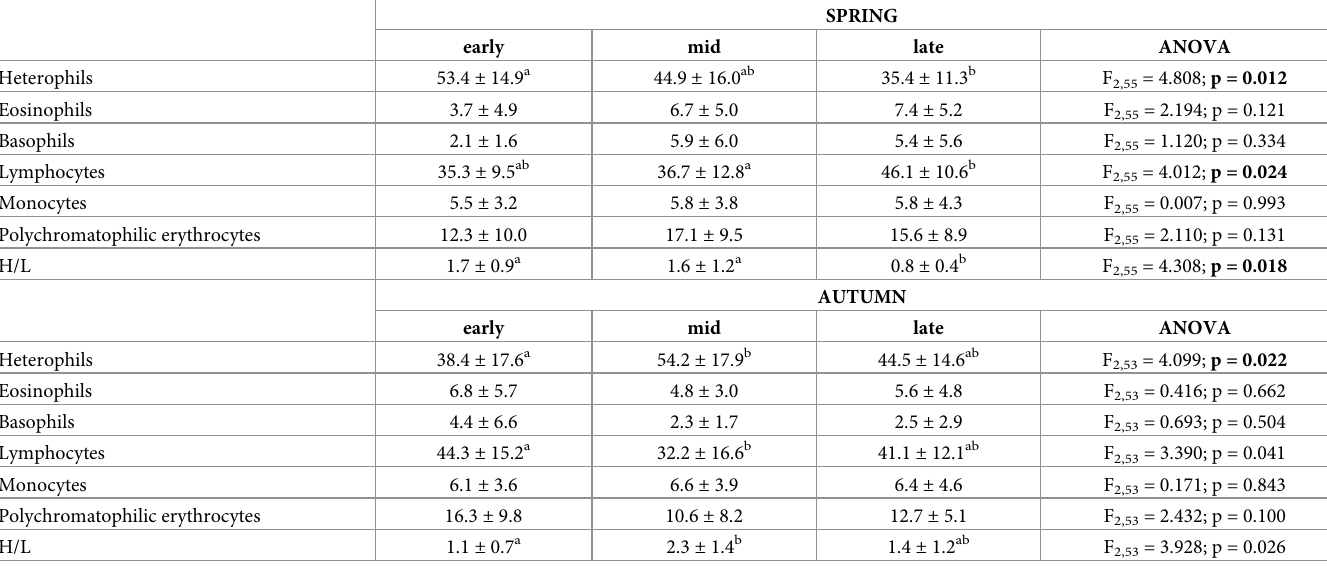
Table 6. Comparison of leucocyte profiles (mean ± SD) among early, mid and late migrant dunlins during spring and autumn migration